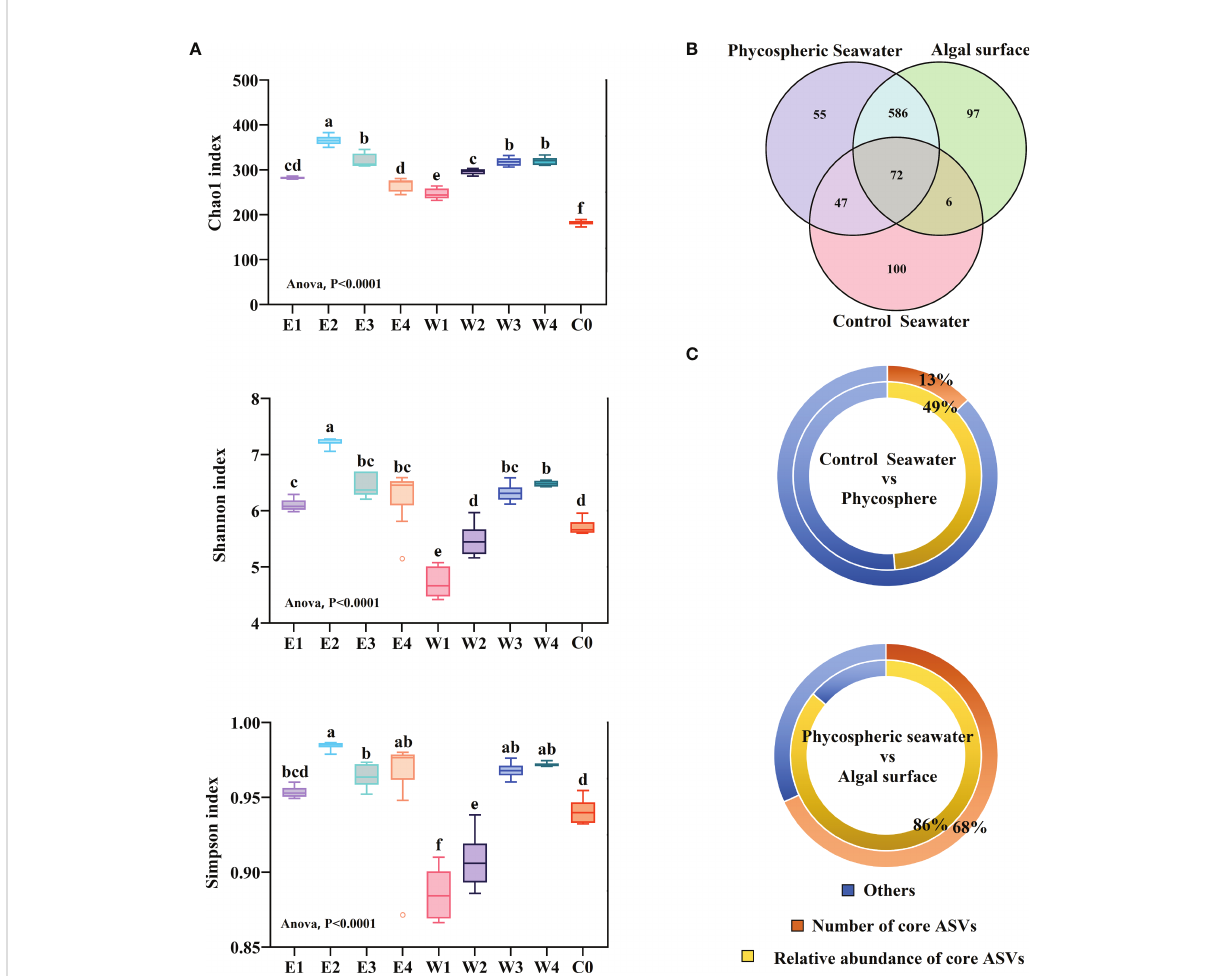
FIGURE 3 Alpha diversity and taxonomic features of the phycospheric bacterial community. E and W refer to the epiphytic and phycospheric seawater bacterial sample groups, respectively. The numbers 1 to 4 refer to the P1 to P4 phases, respectively. C0 refers to the control seawater bacterial sample groups. (A) Alpha diversity indexes of the sample groups. The Chao1, Shannon, and Simpson indexes were calculated to indicate the richness, diversity, and evenness of the bacterial community, respectively. The error bars represent standard deviations (n = 6). Different letters above the bars indicate signi fi cantly different values (one-way ANOVA, P < 0.05). (B) Venn diagram analyse shows the common and unique ASVs. The circle in the fi gure represents sample groups, and the number of overlaps represents the number of ASVs shared between the samples. The numbers without overlap represent the number of unique ASVs in the sample. (C) Percentage and relative abundance of the core ASVs in all